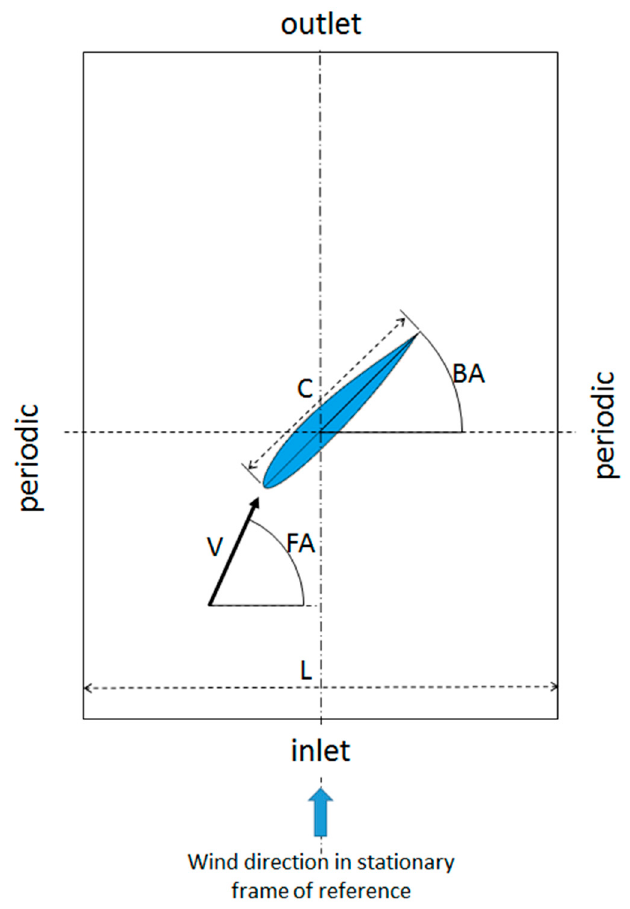
Figure 2. Solution domain and boundaries.